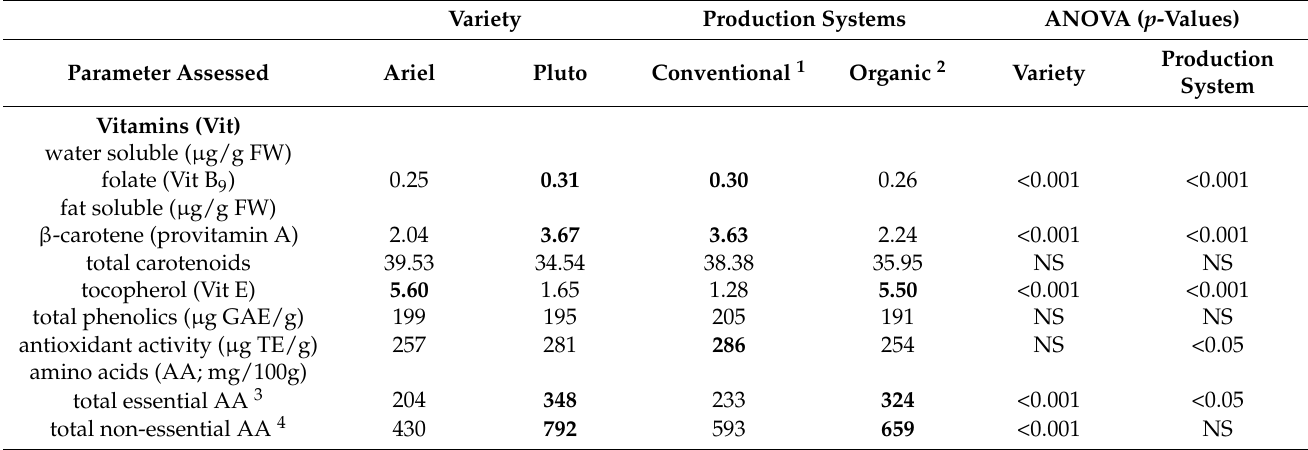
Table 2. Effect of variety/F1-hybrid (Ariel versus Pluto) and production systems (conventional vs. organic) on antioxidant activity/capacity and concentrations of nutritionally relevant vitamins, total phenolics and amino-acids (values shown are main effect means; results are from a single field experiment in Spain; data from [159].